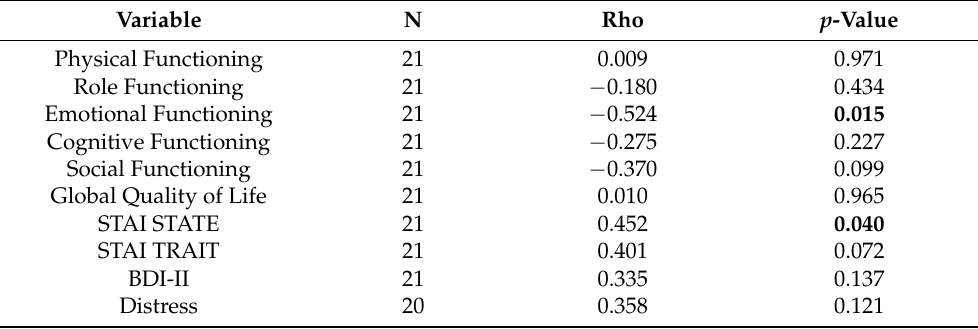
Table 5. Spearman’s correlation coefficient between psychometric variables and concern about postponing